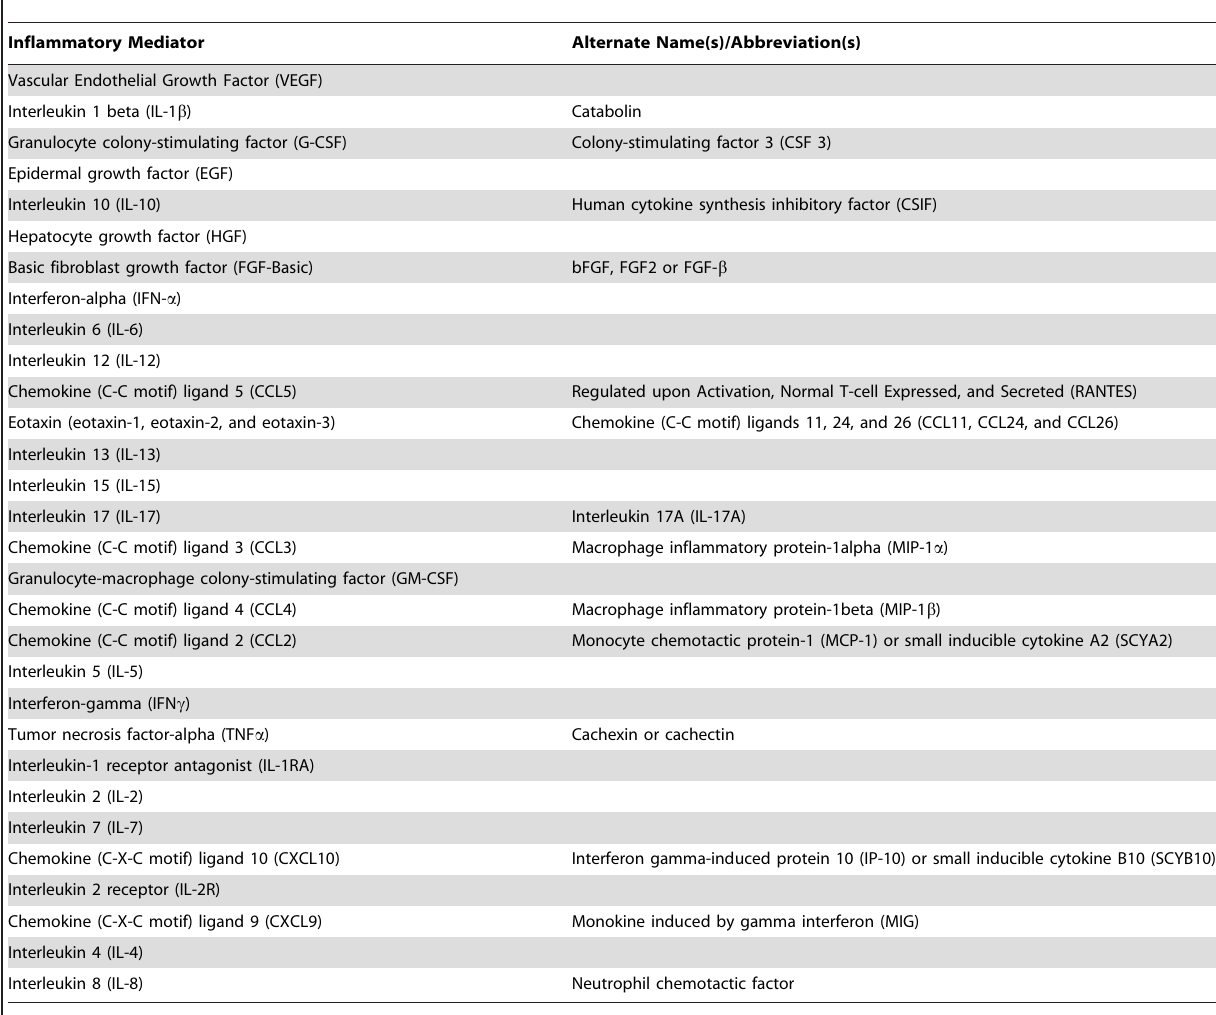
Table 1. Thirty inflammatory mediators (cytokines, chemokines, and growth factors) measured in the circulation of study subjects.